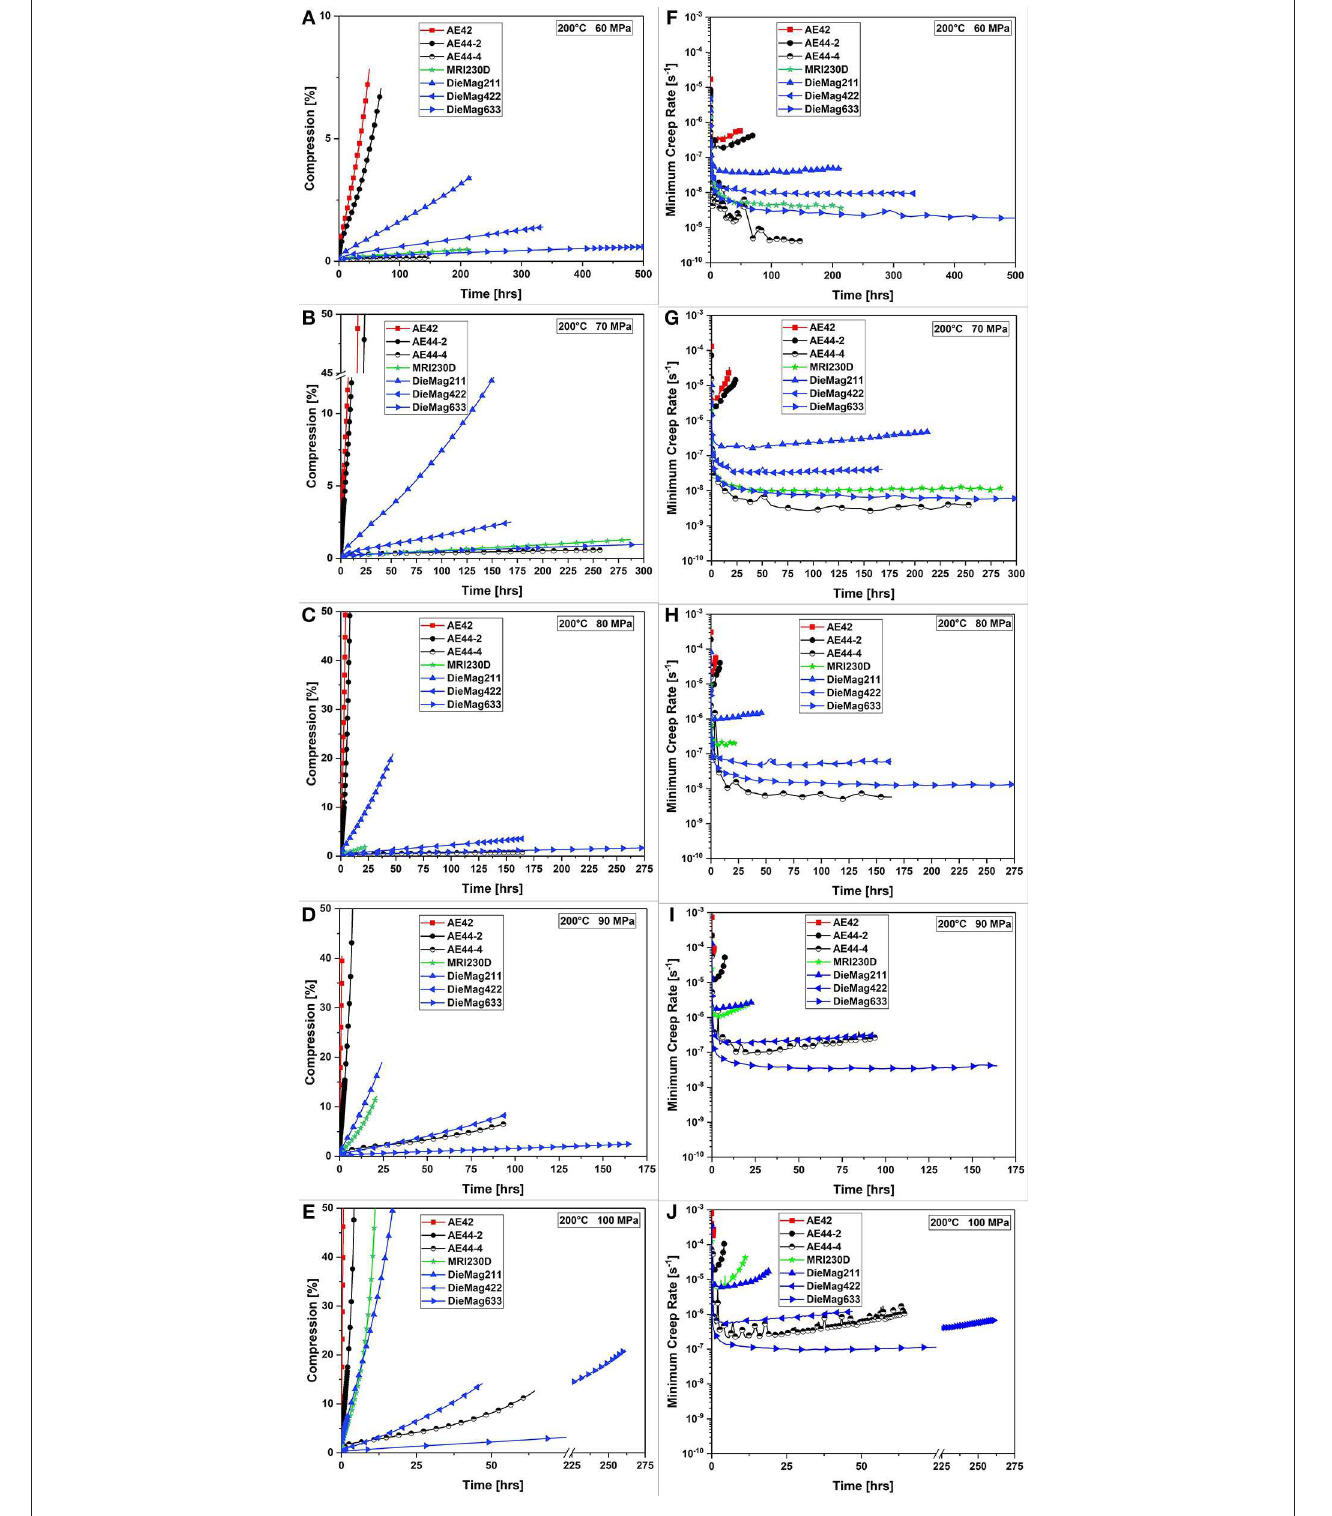
FIGURE 1 | Creep strain curves (A–E) and creep rate curves (F–J) of creep tests at 200 ◦ C and 60–100 MPa applied stress.